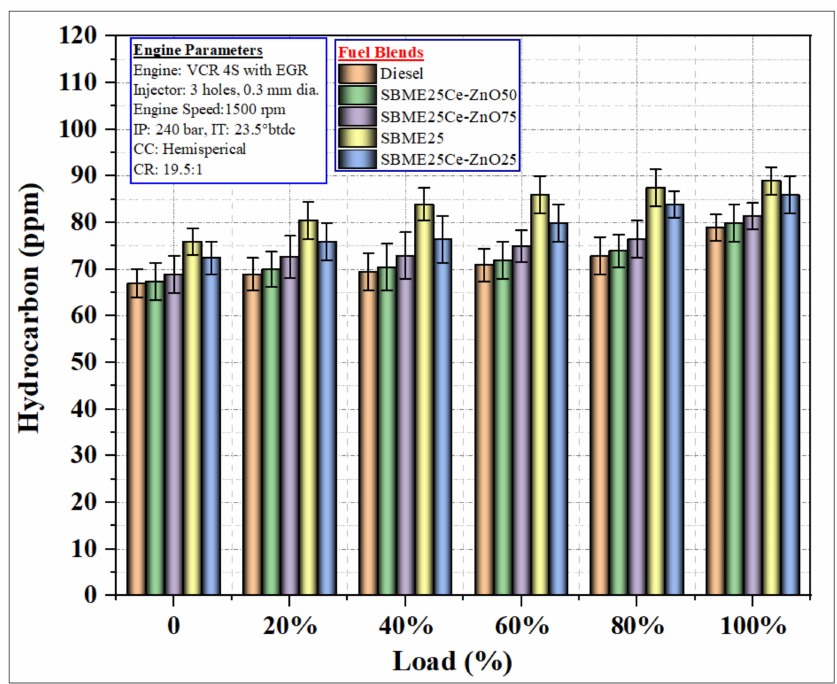
Figure 13. Variation of HC with load for di ff erent fuel